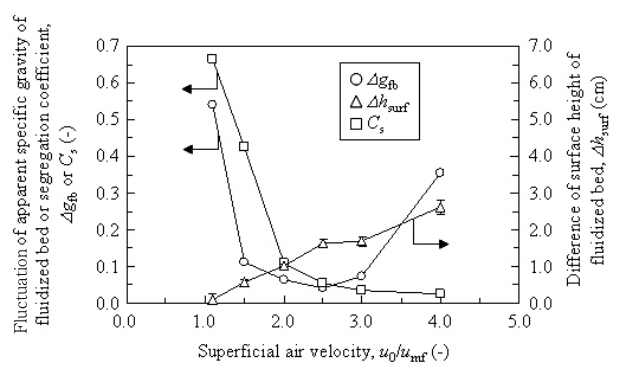
Fig.4 Dependences of the fluctuation of g fb , segregation coefficient and difference of surface height of fluidization on u 0 / u mf at V G.B. = 0.4. (Mixture of P.S.(355~425 μ m, u mf = 4.7 ± 0.4 cm/s) and G.B. (150~180 μ m, u mf = 2.9 ± 0.1